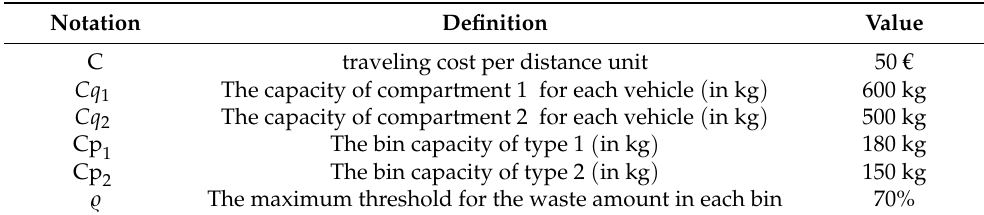
Table 1. Data Table 1. Data values.